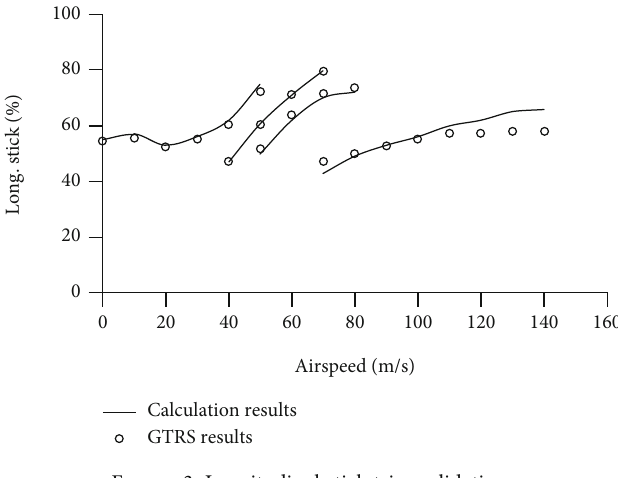
Figure 3: Longitudinal stick trim validation. Table 2: Hover mode eigenvalues